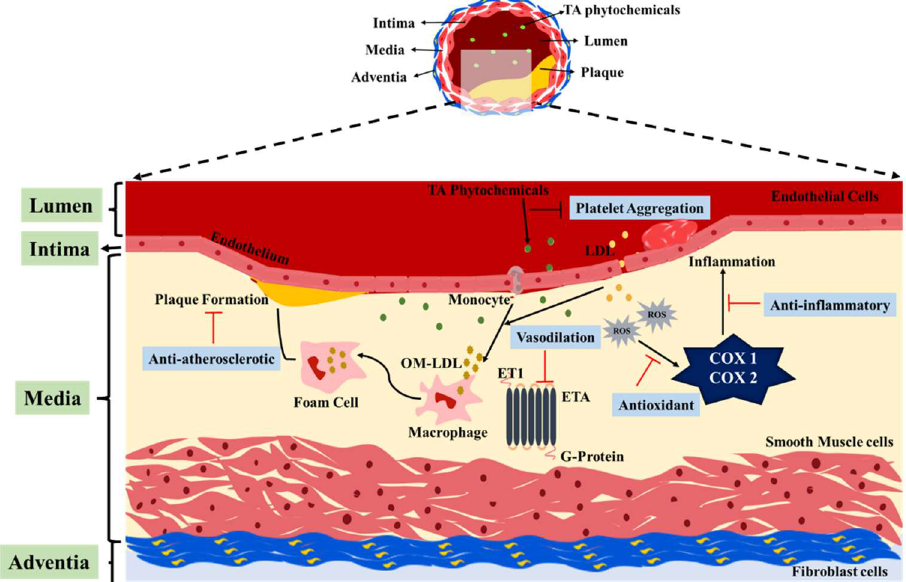
Figure 4. Cardioprotective mechanism of action of TA.